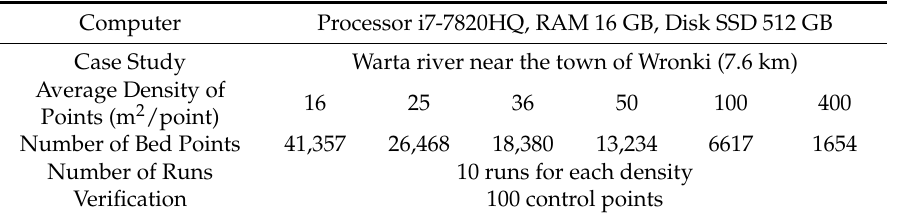
Figure 10. Comparison of selected cross-sections for the Ner river: ( a ) Map with locations of the cross-sections used for comparison; ( b – d ) compared cross-sections. Table 2. Parameters of efficiency tests.